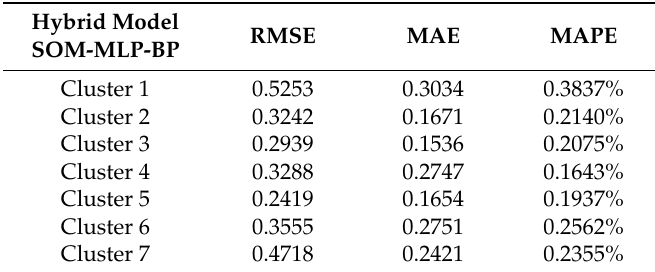
Table 5. Performance evaluation of models for the validation